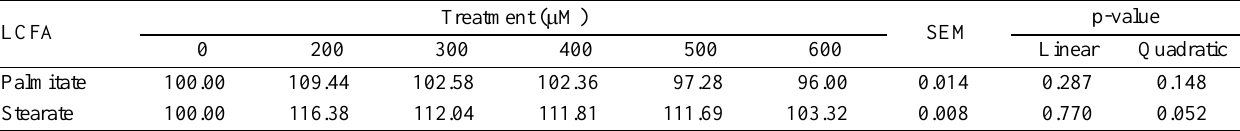
Table 2. Effect of palmitate and stearate on BMECs proliferation LCFA